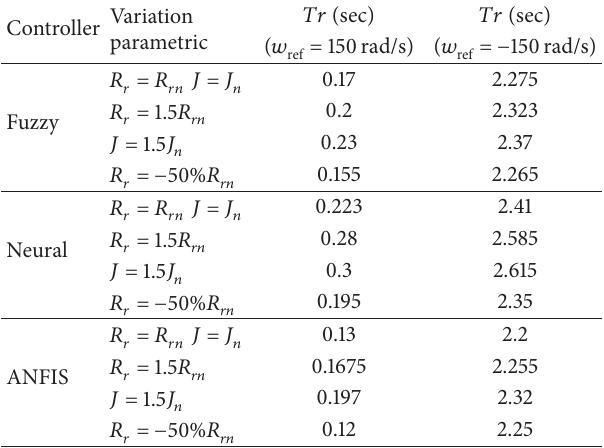
Figure 7: The hybrid control (neurofuzzy). Table 2: Response time of the machine with three types of regulator during the variation parametric.